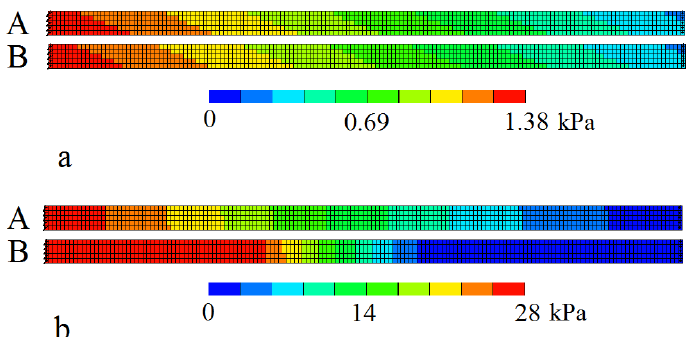
Figure 13. Simulated pressure distributions in sand-packs A and B during water-flooding: ( a ) before gel treatment; and ( b ) after gel treatment.